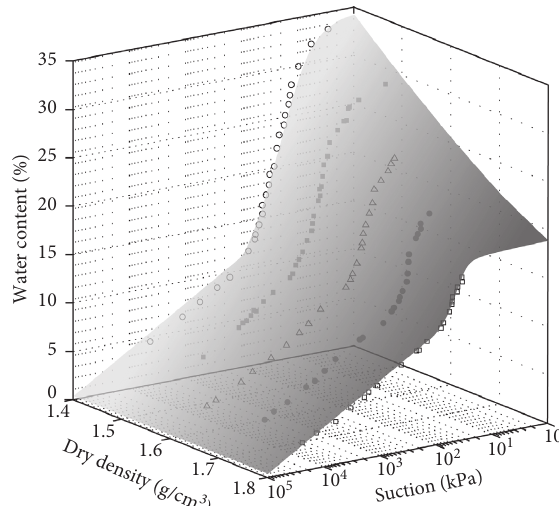
Figure 10: Unified function of θ